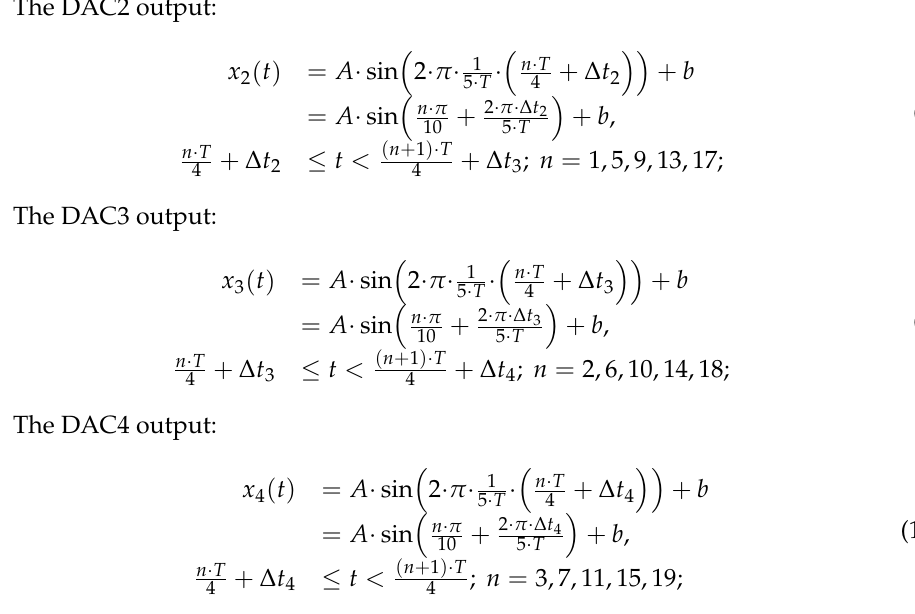
Figure 10. The relationship diagram of amplitude error when the time error is ∆ t . When DAC2, DAC3 and DAC4 output waveforms and the output time error after multiplexer switching are ∆ t 2, ∆ t 3 and ∆ t 4, respectively, the output waveforms of DAC2, DAC3 and DAC4 after passing through the multiplexer can be expressed as